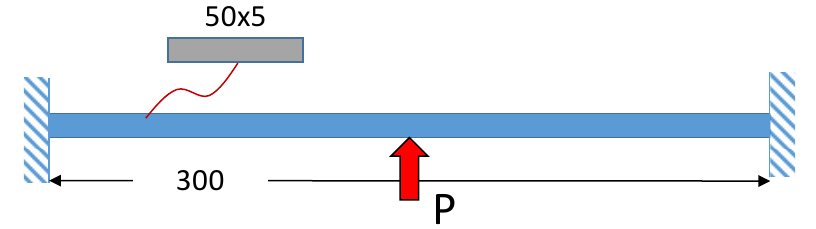
Figure 4. Geometrical parameters and boundary conditions of the host beam (unit: mm).